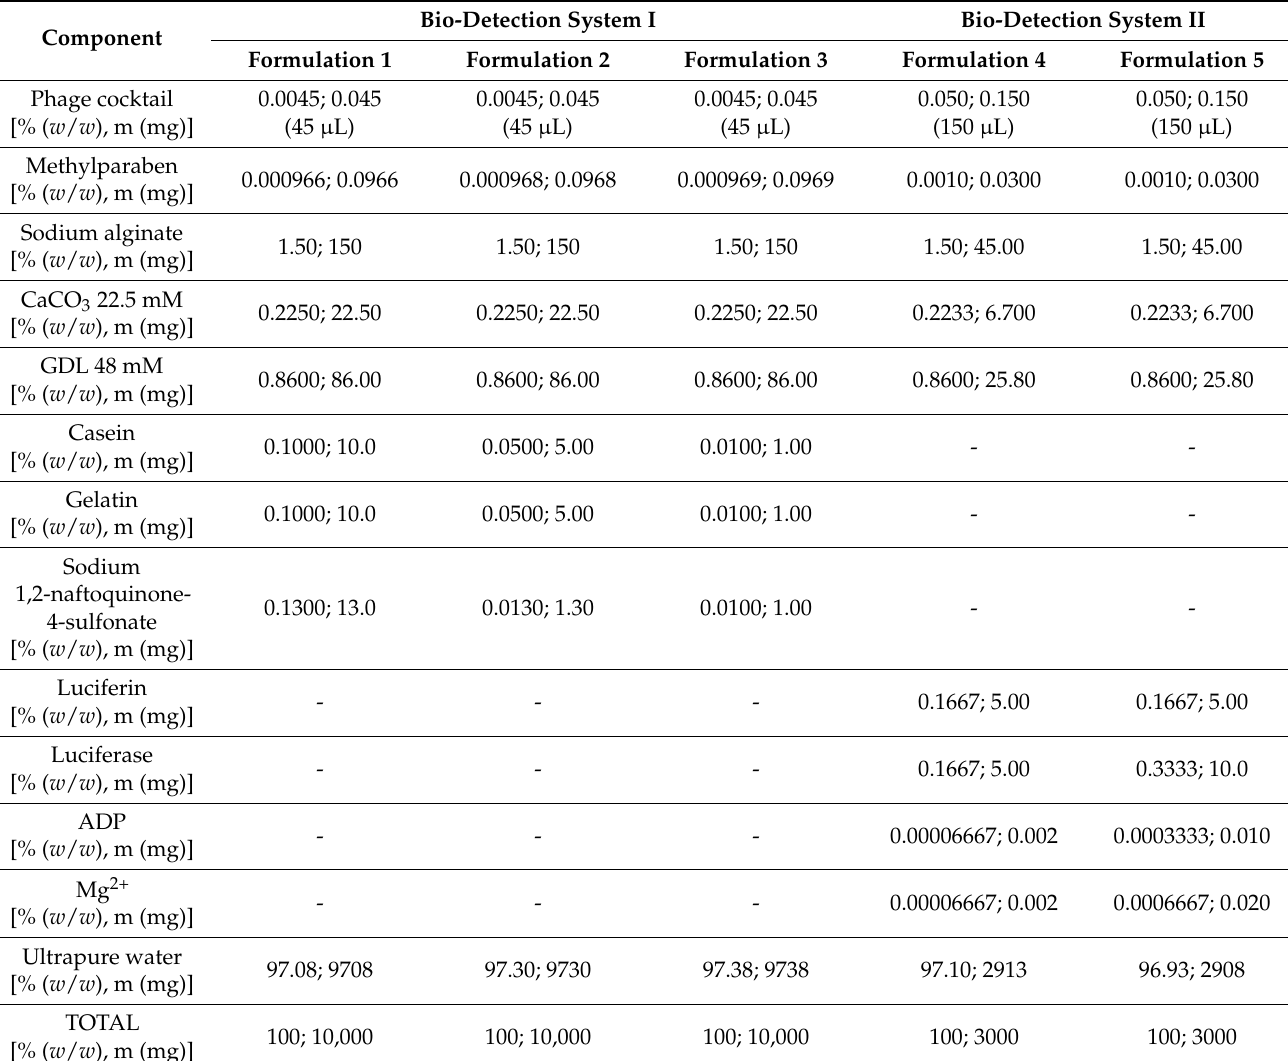
Table 1. Final compositions of the bacterial bio-detection systems encompassing calcium alginate biopolymeric matrices containing entrapped phage